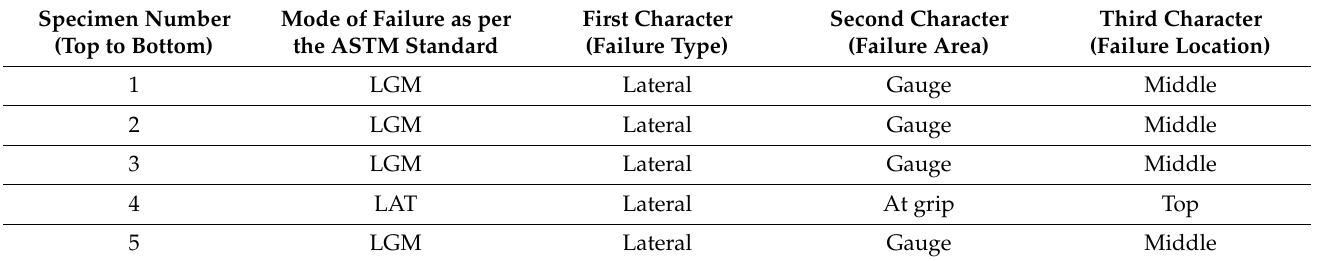
Table 7. Modes of failure—hybrid eggshell filled composite